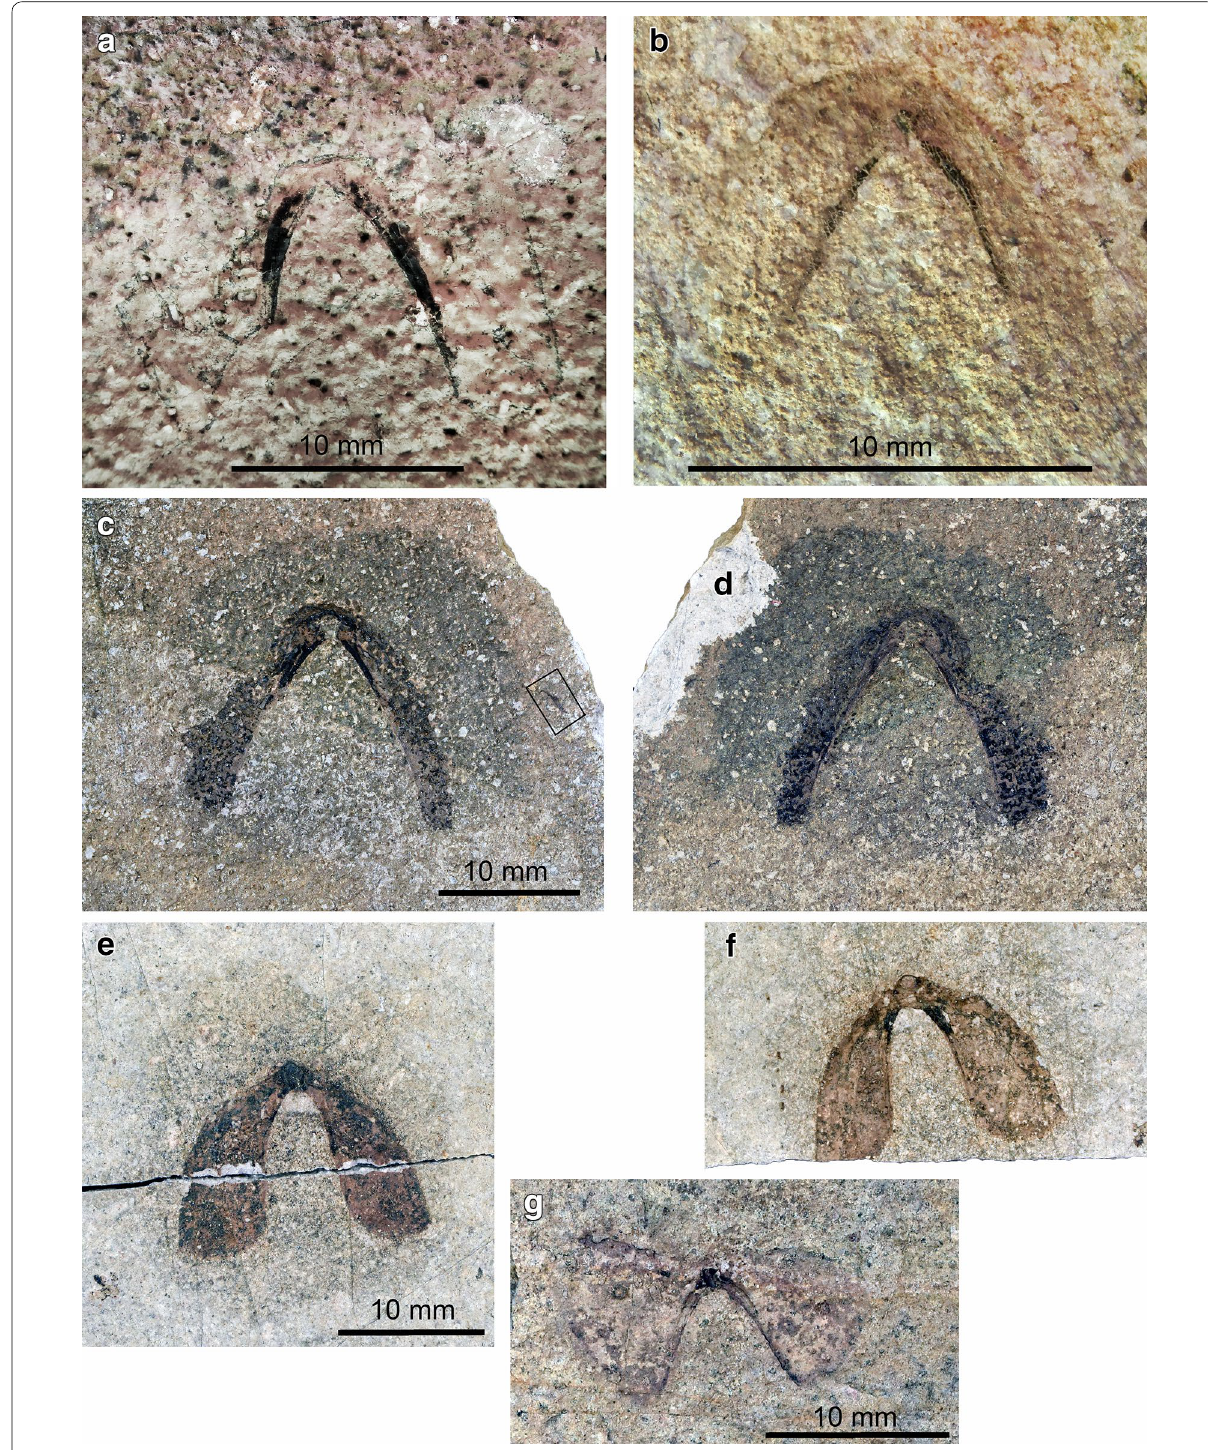
Fig. 4 Cephalopod jaws from the Maastrichtian of continental Greece. Note the halos around all specimens. a , b Two poorly preserved lower jaws of a teudopsein coleoid. a SGL1_43. b SGL1_39. c , d Lower jaw of a teudopsein coleoid; SGL1_22a,b. e , f Lower jaws of a teudopsein coleoid; SGL1_35a,b. g Lower jaw of a cephalopod, probably of an ammonite, i.e. an anaptychus;